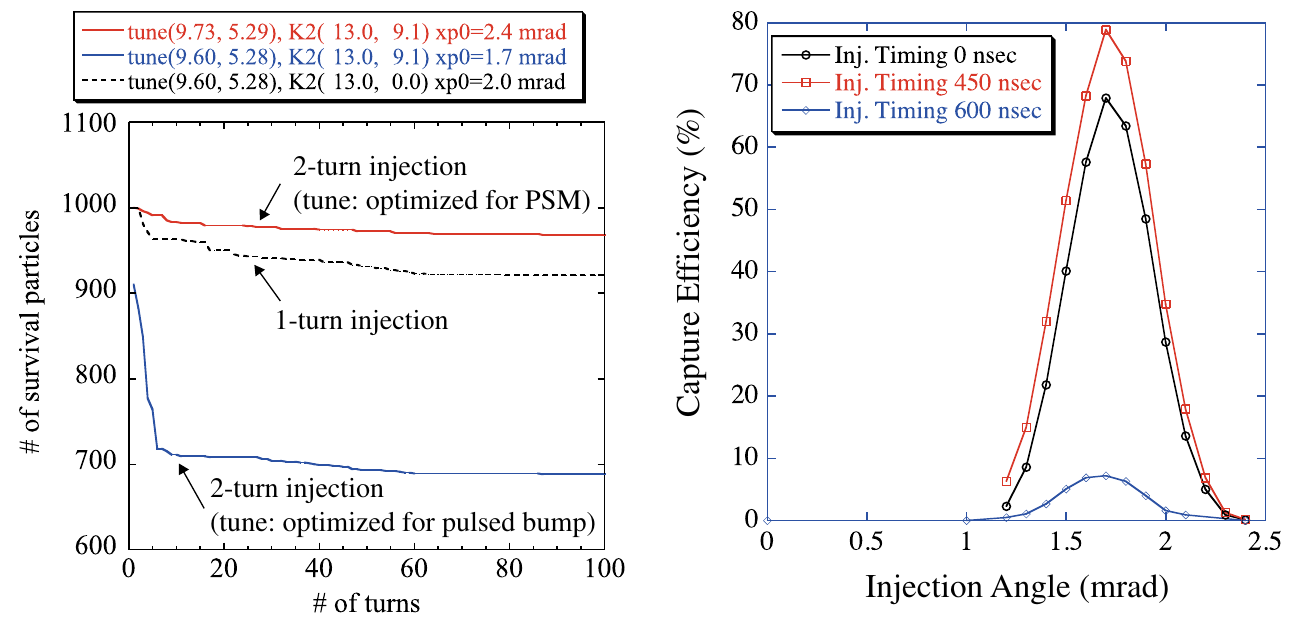
FIG. 9. (Color) The number of survival particles in the PSM injection plotted as a function of turn number. Parameters in the legend show the operating tune ð (cid:7) x ; (cid:7) y Þ , the field strength of the PSM (1st kick, 2nd kick), and the injection angle ( x 0 0